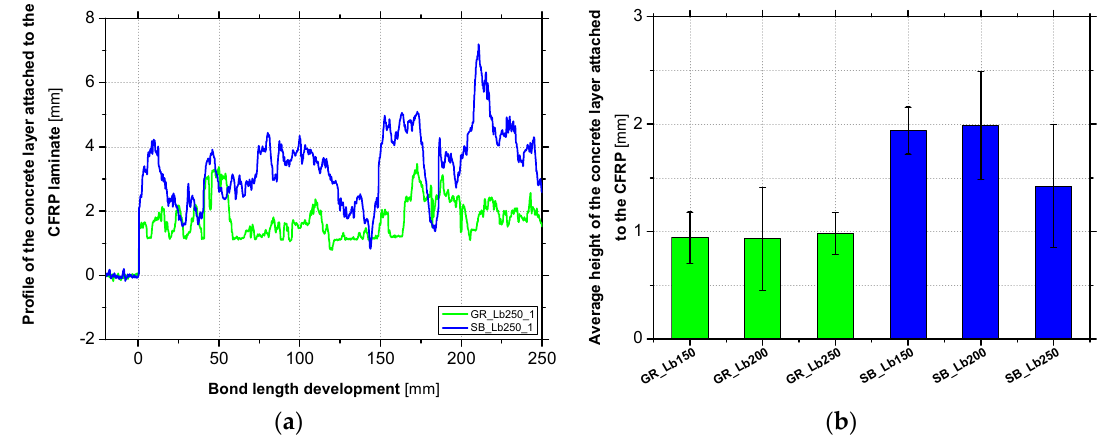
Figure 7. Concrete attached to the CFRP after debonding failure for the series Lb250 ( a ) and the average height of the attached concrete layer ( b ).